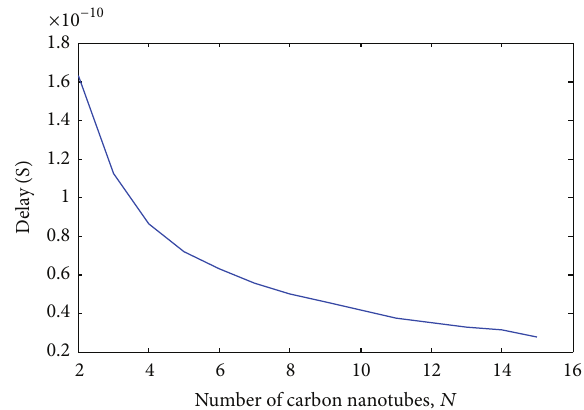
Figure 7: Effect of diameter variations on PDP for pure technology design.